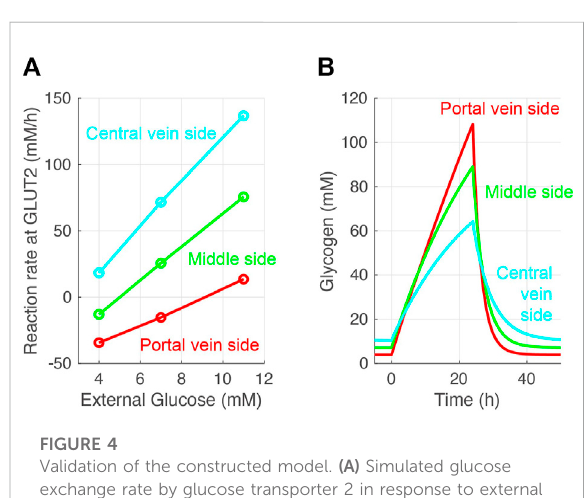
FIGURE 4 Validation of the constructed model. (A) Simulated glucose exchange rate by glucose transporter 2 in response to external (blood) glucose concentration. (B) Simulated glycogen concentrations over time. Hepatocytes were in a feeding state from 0 to 24 h and in a fasting state for the rest of the simulationtime.Theexternal(blood)glucoseconcentrationswere set to 4 and 11 mM for the fasting and feeding states, respectively. The external lactose concentration was fi xed at 1 mM in all